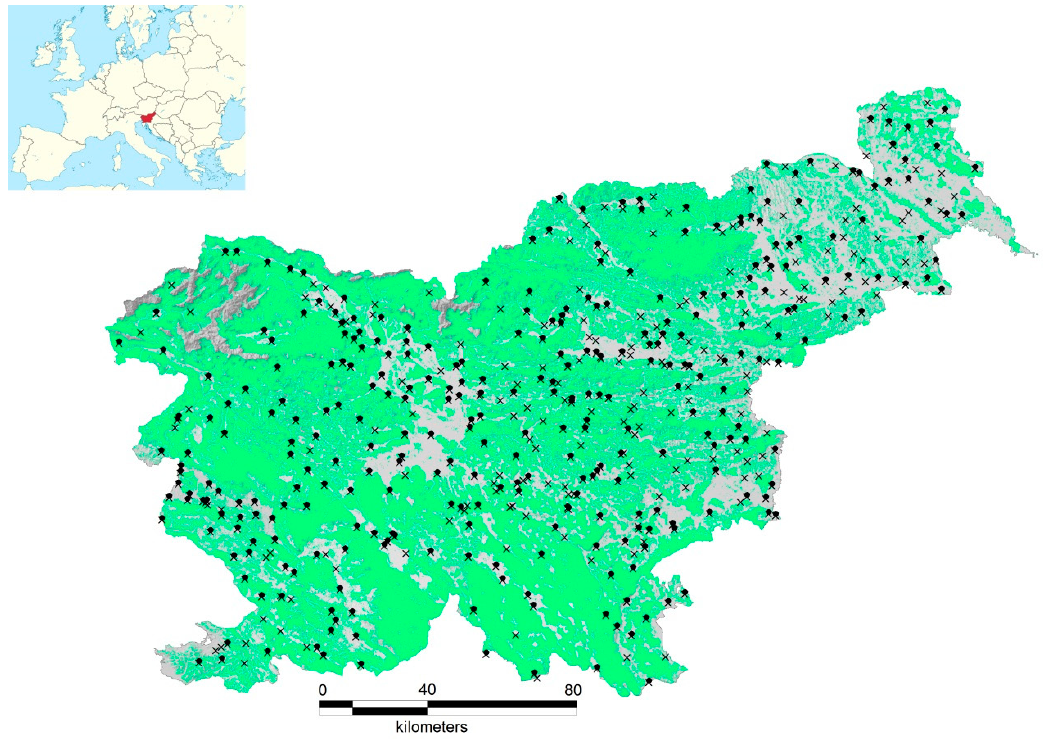
Figure 1. The locations of settlements where the respondents ( • ) and non-respondents ( × ) resided. The green color denotes forest